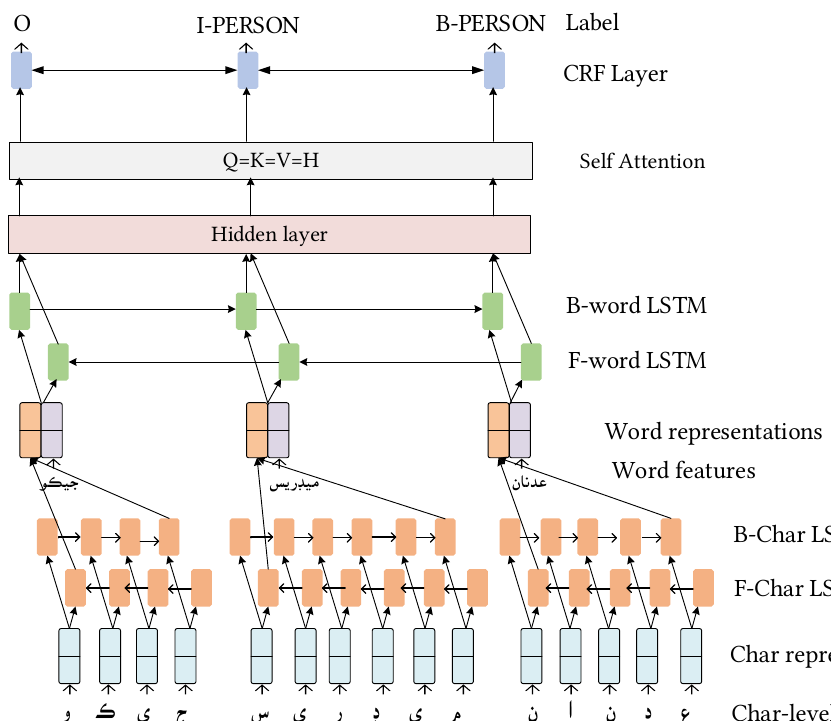
Figure 1. The architecture of our proposed CaBiLSTM model. The initial step is to map each sentence as a sequence of characters to output a label distribution for each character position. Afterwards, the BiLSTM network transforms the sequence of tokens into the word representations. In this way, word-level features are composed of the character-level BiLSTM network. Then, the concatenated output of contextual representations is fed to the self-attention layer through a hidden layer. Finally, the CRF jointly decodes the best chain of NE tags of the given input instead of decoding each label